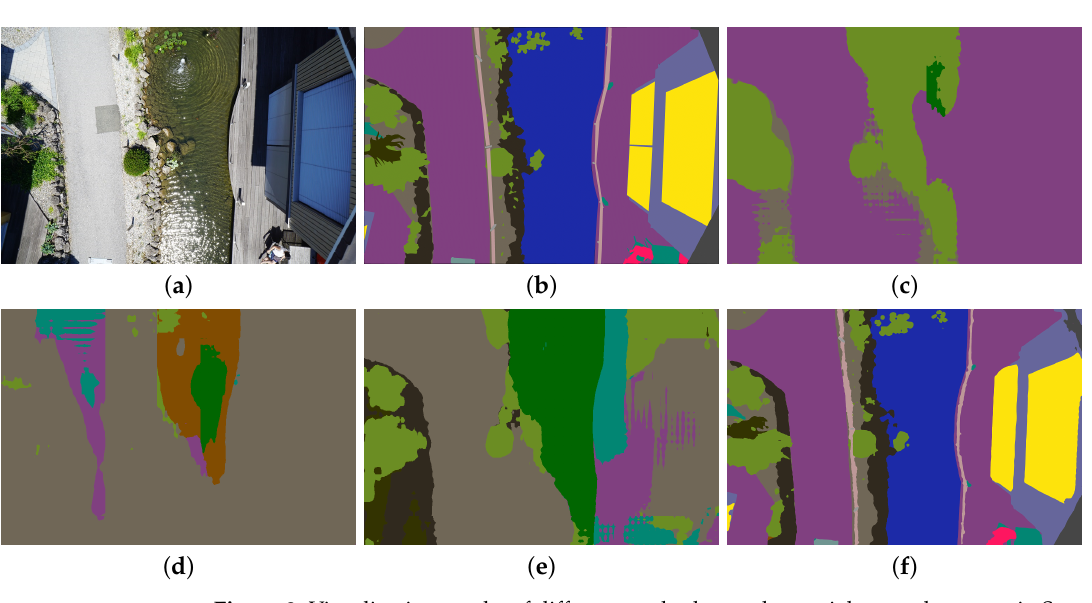
Figure 8. Visualization results of different methods on adversarial example test set in Semantic Drone dataset. ( a ) Adversarial Images. ( b ) Ground Truth. ( c ) MCLNet [13]. ( d ) BSNet [14]. ( e ) SBANet [15]. ( f )